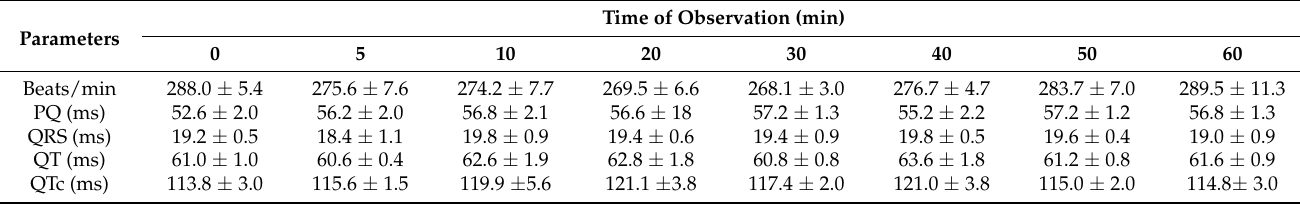
Table 1. Effects of TGB (100 mg/kg i.p. ) on the heart rate and ECG intervals in anesthetized rat (thiopental 75 mg/kg i.p. ). Parameters